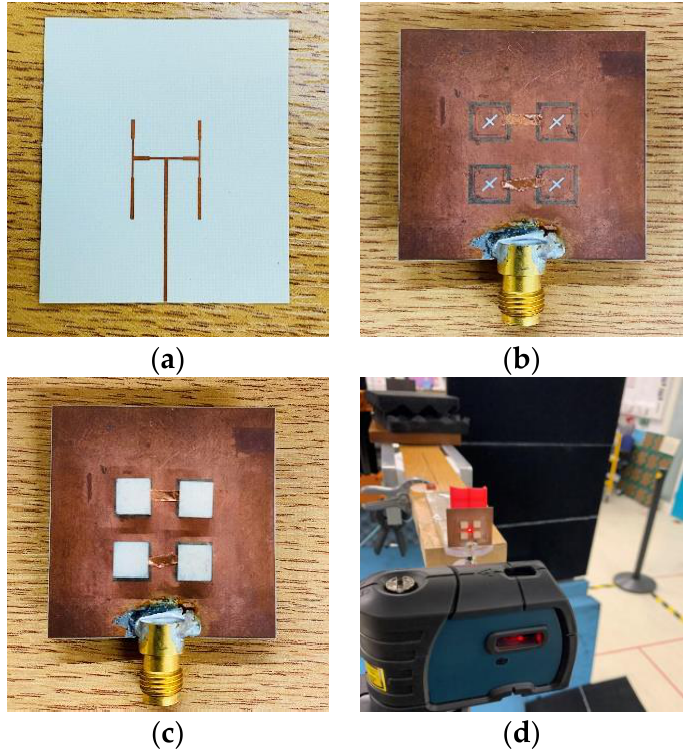
Figure 17. The array prototype: ( a ) back view of the feed network, ( b ) top view of the feed network, ( c ) assembled DRA array, ( d ) measurements system.